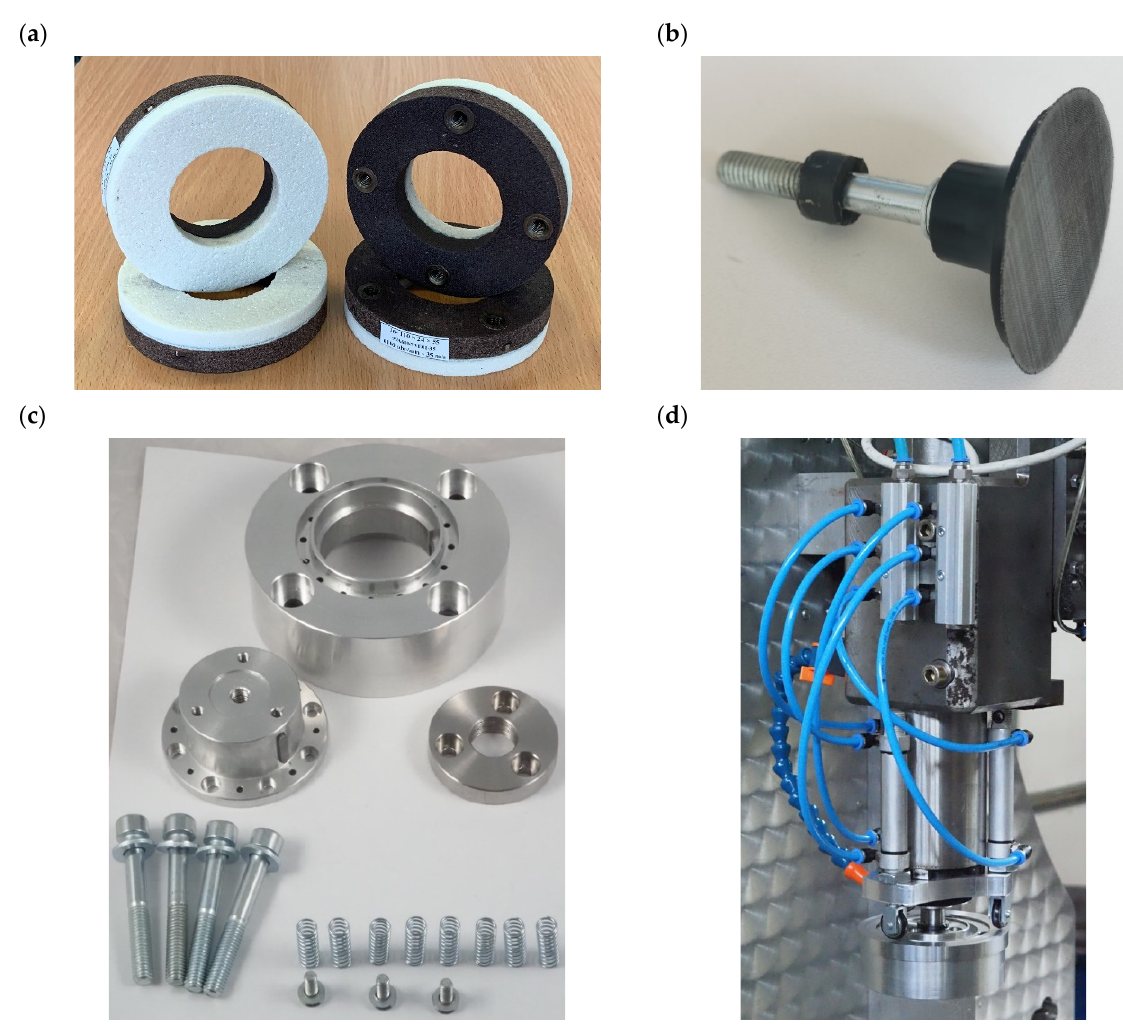
Figure 5. ( a ) ceramic grinding wheel from ANDRE, type 3611-110 × 24 × 55-99A60K9V with four M8 threaded inserts; ( b ) a prone grinding wheel with Trizact ® grains; ( c ) listing the components of dual-tool grinding head; ( d ) dual-tool grinding head mounted on the test bench.